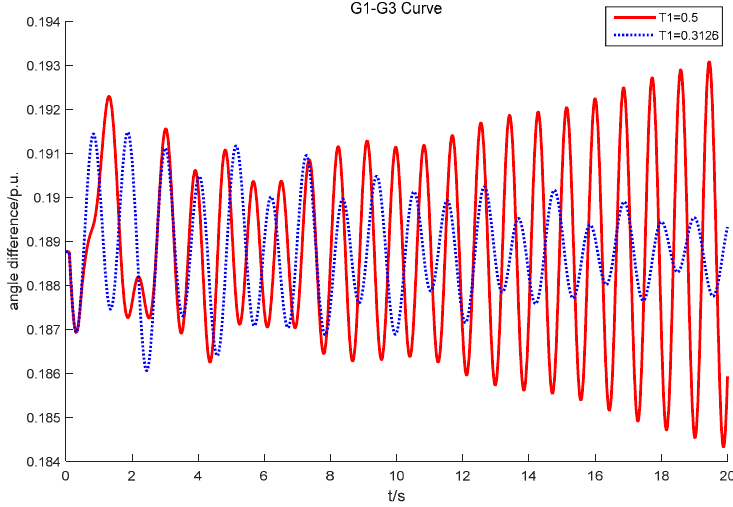
Figure 14. G1–G3 power angle difference curves before and after tuning.